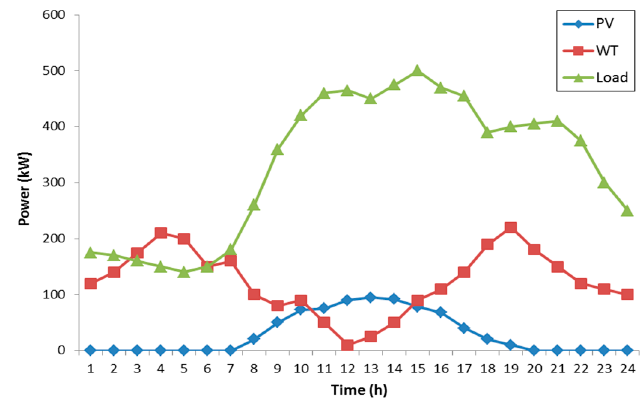
Figure 4. Forecasting power of PV panels and WTs and load for test system.